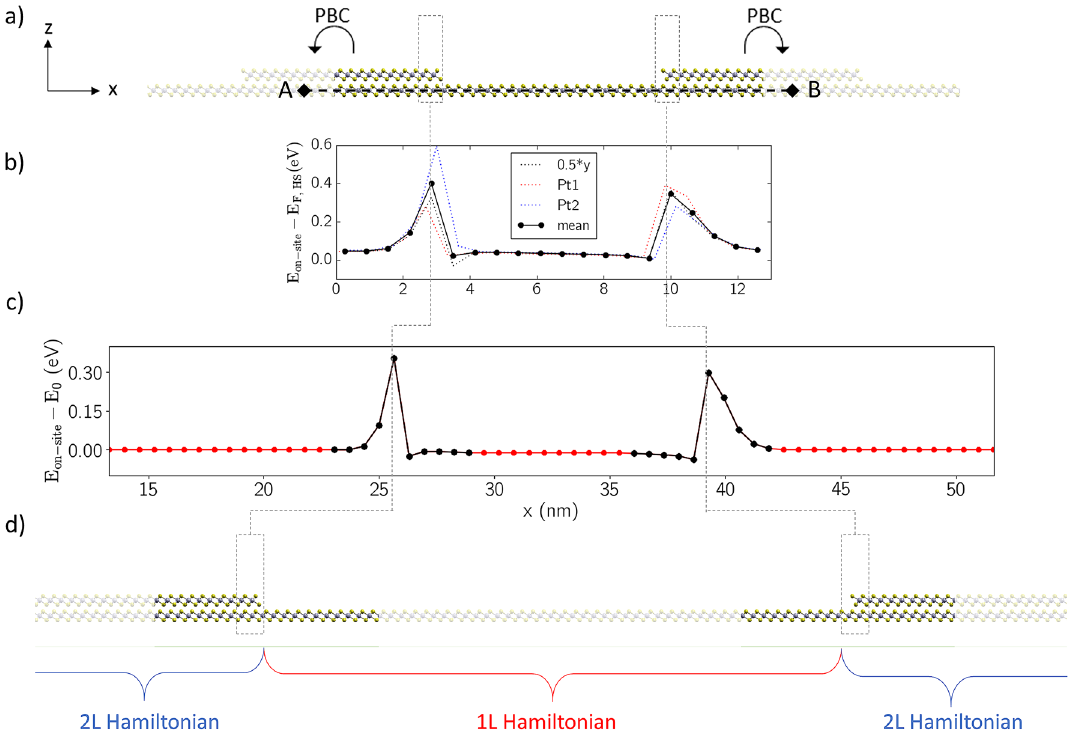
Figure 3. Multi-scale approach to construct the Hamiltonian for a long transistor channel. ( a ) Supercell used to model the heterostructure in DFT, with periodic boundary conditions (PBC) highlighted. ( b ) On-site energy profile E on-site along the black dashed line in ( a ), aligned w.r.t. the HS Fermi level E F, HS . Dotted lines correspond to different y coordinates of the line, namely those of the Pt atoms indicated in Fig. 2a or the midpoint between them. The average of these curves is shown in solid black. The distance between points along x is a x . ( c ) Profile of E on-site along a LH constructed by elongating 1L and 2L regions and using the potential from panel ( b ) around the interfaces (black), plotted w.r.t. E 0 = E on-site ( x = 0), i.e., the left-most value in panel ( b ). The potential elsewhere (in red) is fixed to that of the bulk-most sites in the 2L (1L) regions. ( d ) Geometry of the final device, highlighting the regions in which the 1L (2L) MLWF Hamiltonians have been used. Dotted lines are drawn to guide the eye throughout the multi-scale procedure. This figure was made using VMD [v1.9.1, https:// www. ks. uiuc. edu/ Resea rch/ vmd/ vmd-1. 9.1] and Matplotlib [v3.3.3, https:// doi. org/ 10. 5281/ zenodo. 42689